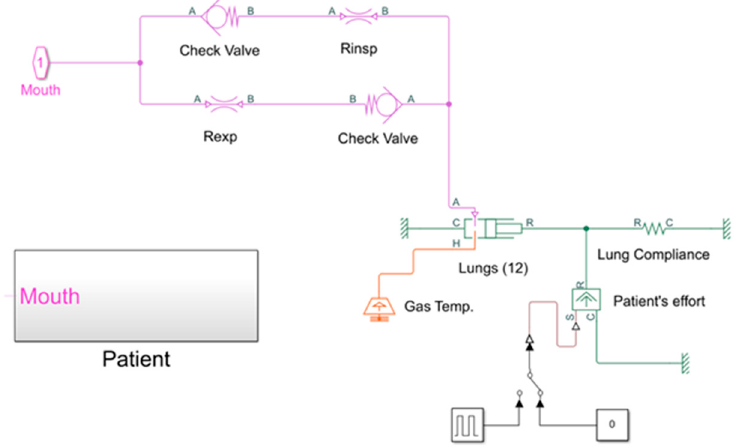
Figure 14. Subroutine reproducing the patient’s trachea and lungs.